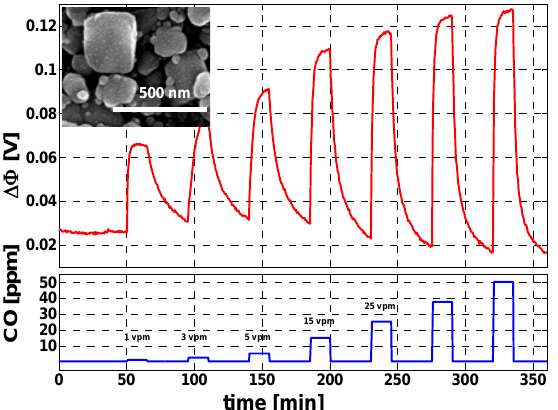
Figure 18. Sensing characteristics towards CO in ambient air of a GasFET equipped with a polycrystalline sensing layer of Pd-doped SnO with the impregnated Pd clusters are shown. Measurements were conducted at room temperature after a preceding thermal activation. Reprinted from [162] with permission from